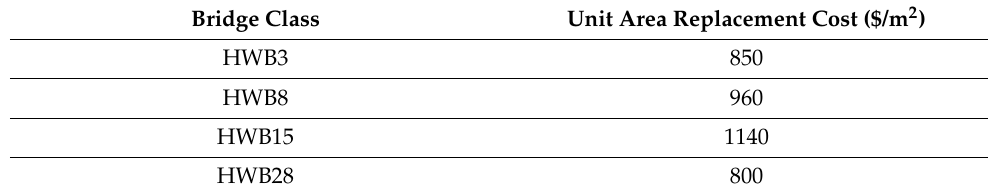
Table 9. Replacement value per bridge